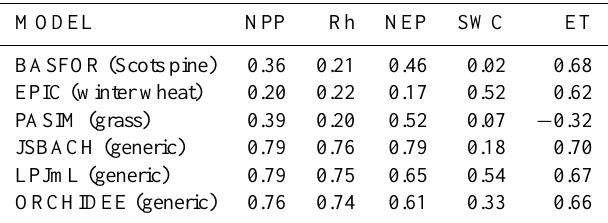
Table 3. Correlations of NDVI with model outputs at the Euro- pean scale (where n is model-specific, see Table 1). NDVI and out- puts are averages for April–September over multiple years (NDVI: 1982–2010, outputs: 1971–2000). Variables as in Table 2.